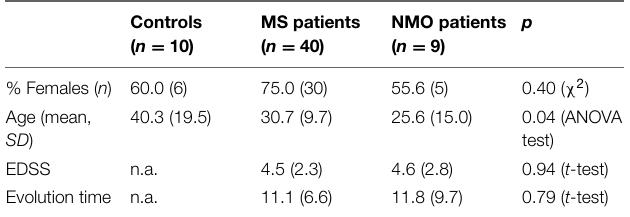
TABLE 3 | General characteristics of series